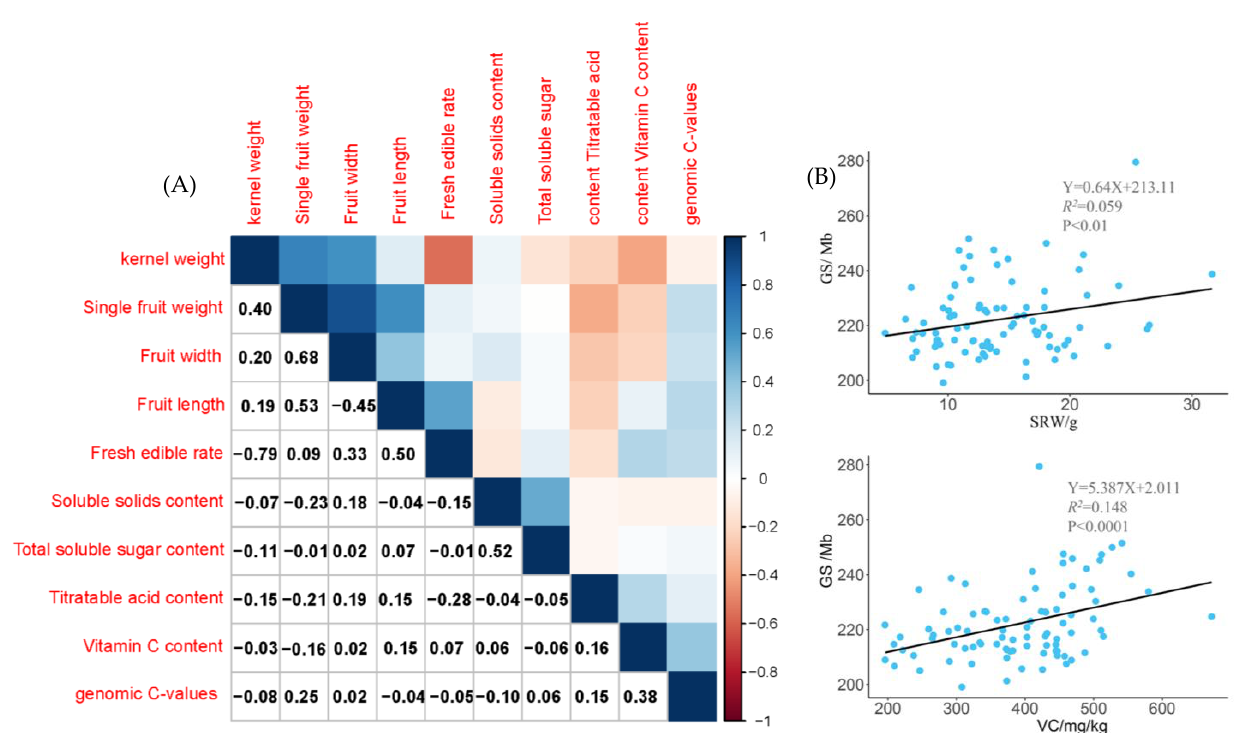
Figure 7. Correlation analysis and linear regression fitting between genomic C-values and fruit traits. ( A ) The negative correlation is shown in blue, positive correlation in orange; the darker the color, the higher the correlation coefficient. ( B ) The coefficient of determination (square of Pearson correlation coefficient) between genomic C-values and single-fruit weight was 0.059 and vitamin C content was 0.148.